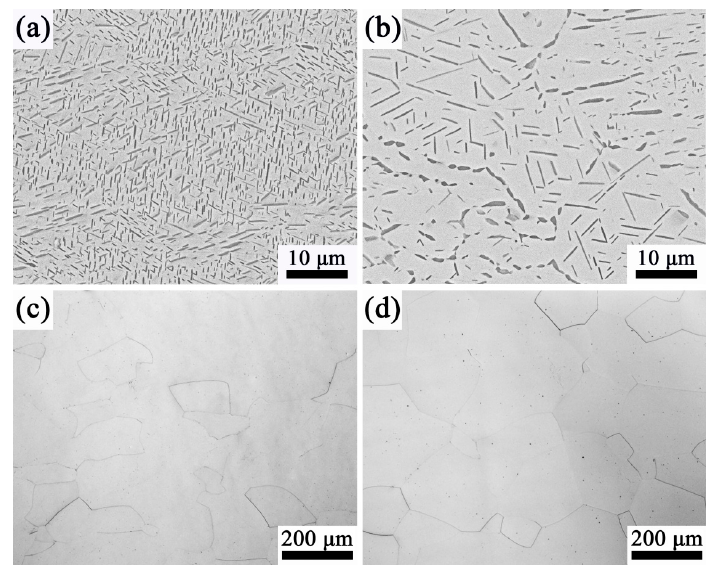
Figure 3. Micrographs of the specimen that was solution-treated at different temperatures: ( a ) 760 °C for 1 h; ( b ) 780 °C for 1 h; ( c ) 820 °C for 0.5 h; ( d ) 840 °C for 0.5 h.